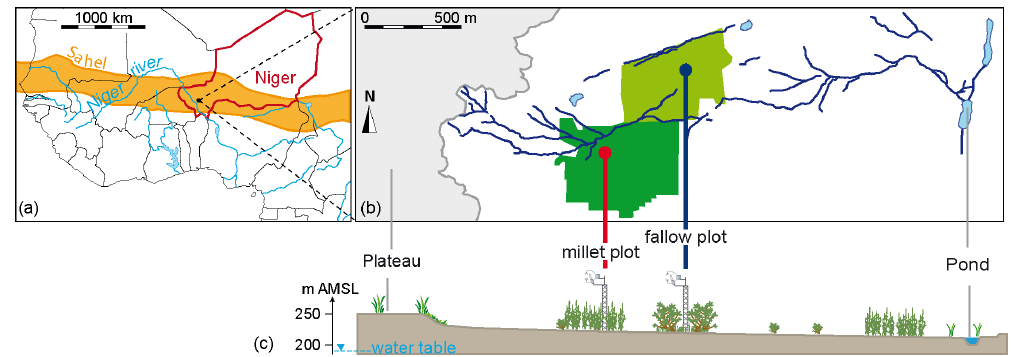
Figure 1. Situation of study plots: (a) location in Sahelian southwestern Niger, West Africa, (b) planar and (c) cross-sectional views of Wankama hillslope with plot locations (modified after Ramier et al., 2009; vegetation and towers not sketched to scale in c